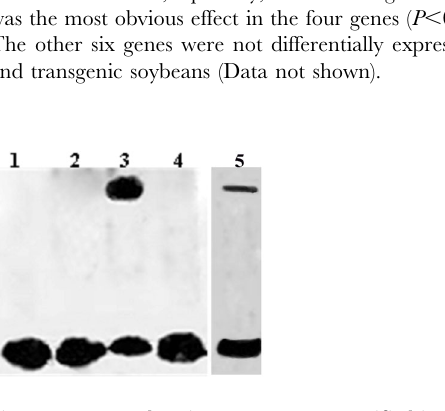
Figure 4. EMSA showing OsDREB2A specific binding to the DRE element. Lane 1, free labeled DRE probes; lane 2, GST proteins control; lane 3, GST-OsDREB2A fusion proteins plus labeled the WT DRE element; lane 4, GST-OsDREB2A fusion proteins plus labeled the mutant DRE element; and lane 5, GST-OsDREB2A fusion proteins plus unlabeled and labeled DRE element.